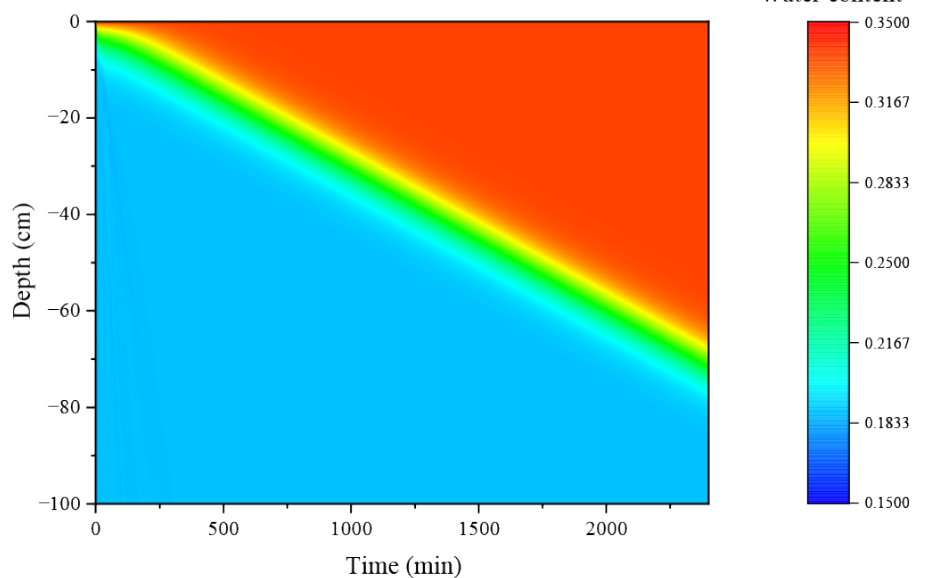
Figure 13. The results of the numerical prediction of soil–water infiltration in heavy-loam soils over